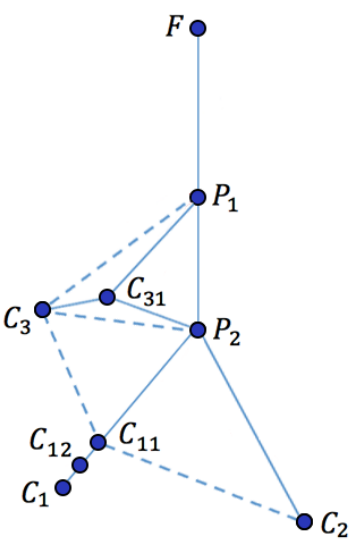
Figure 5. Present case situation.